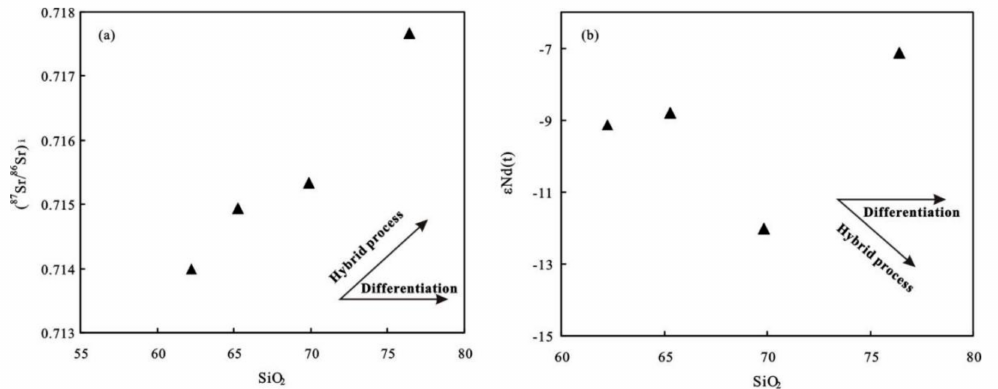
Figure 9. SiO 2 –( 87 Sr / 86 Sr) i ( a ) and SiO 2 – ε Nd (t) ( b ) diagram for biotite granite in the Gaudeanmus study area, Namibia.